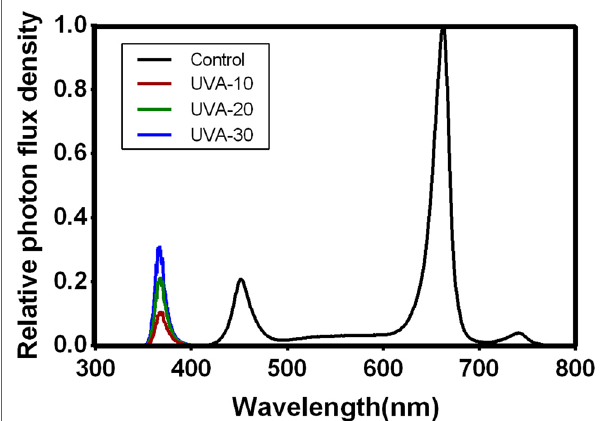
FIgURe 1 | Relative photon flux density in the four treatments. The spectral distribution was measured by a spectrometer (AVANTES 2500, The Netherlands).